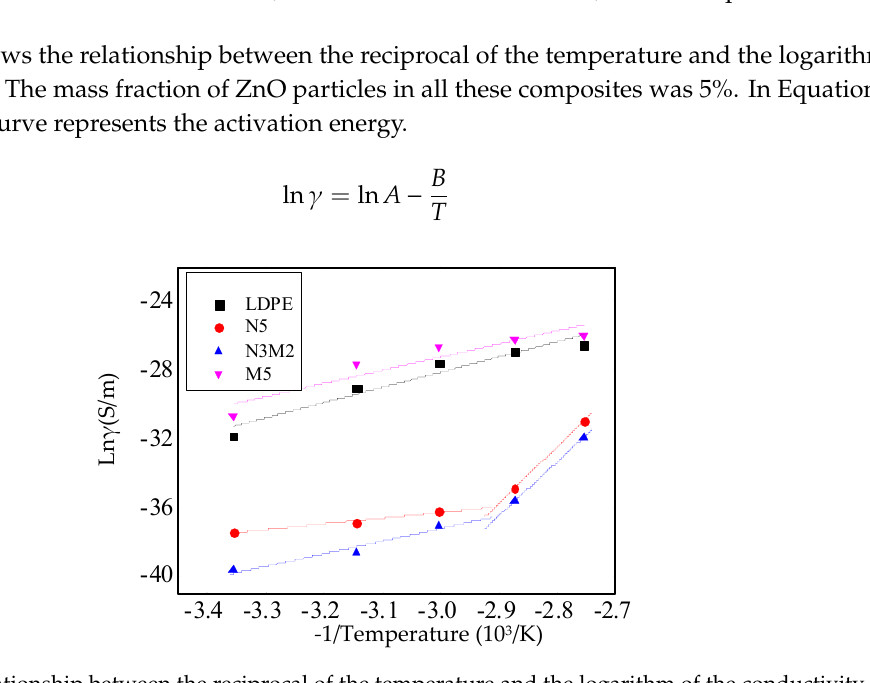
Figure 7. Relationship between the reciprocal of the temperature and the logarithm of the conductivity of different samples.